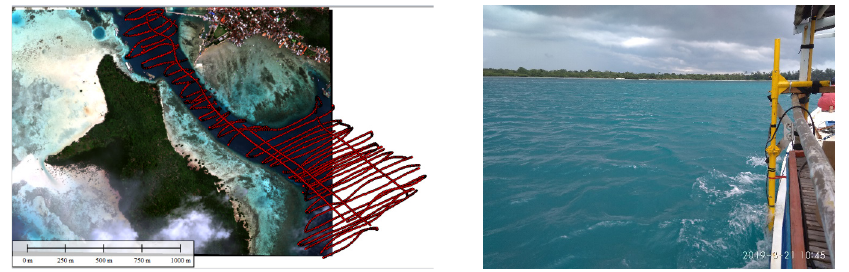
Figure 1. Ship route map for bathymetric survey and field documentation (source: Basith & Prastyani,